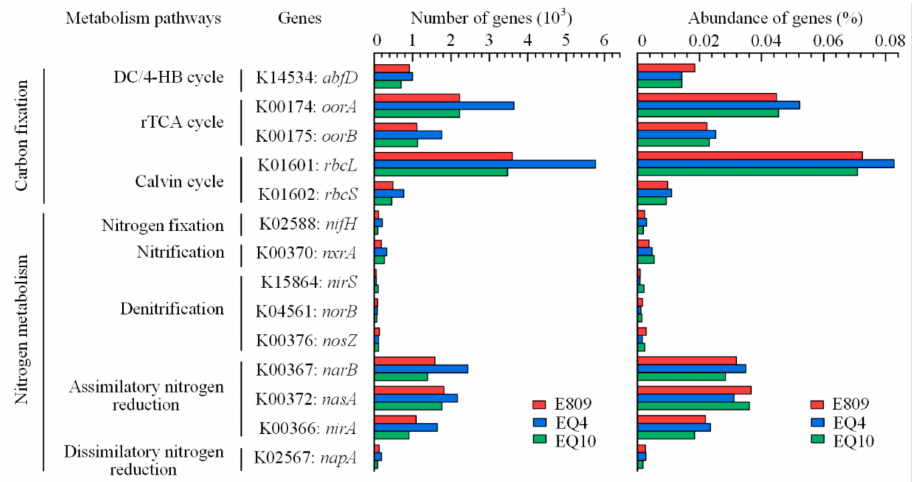
Figure 6. The relative abundances of genes encoding key enzymes of carbon fixation and nitrogen metabolism